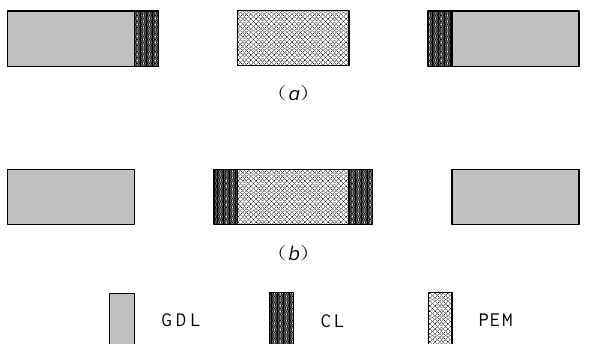
Figure 1. Schematic diagram of the preparation process of MEA. ( a ) GDE-PEM approach; ( b ) CCM- GDL approach.